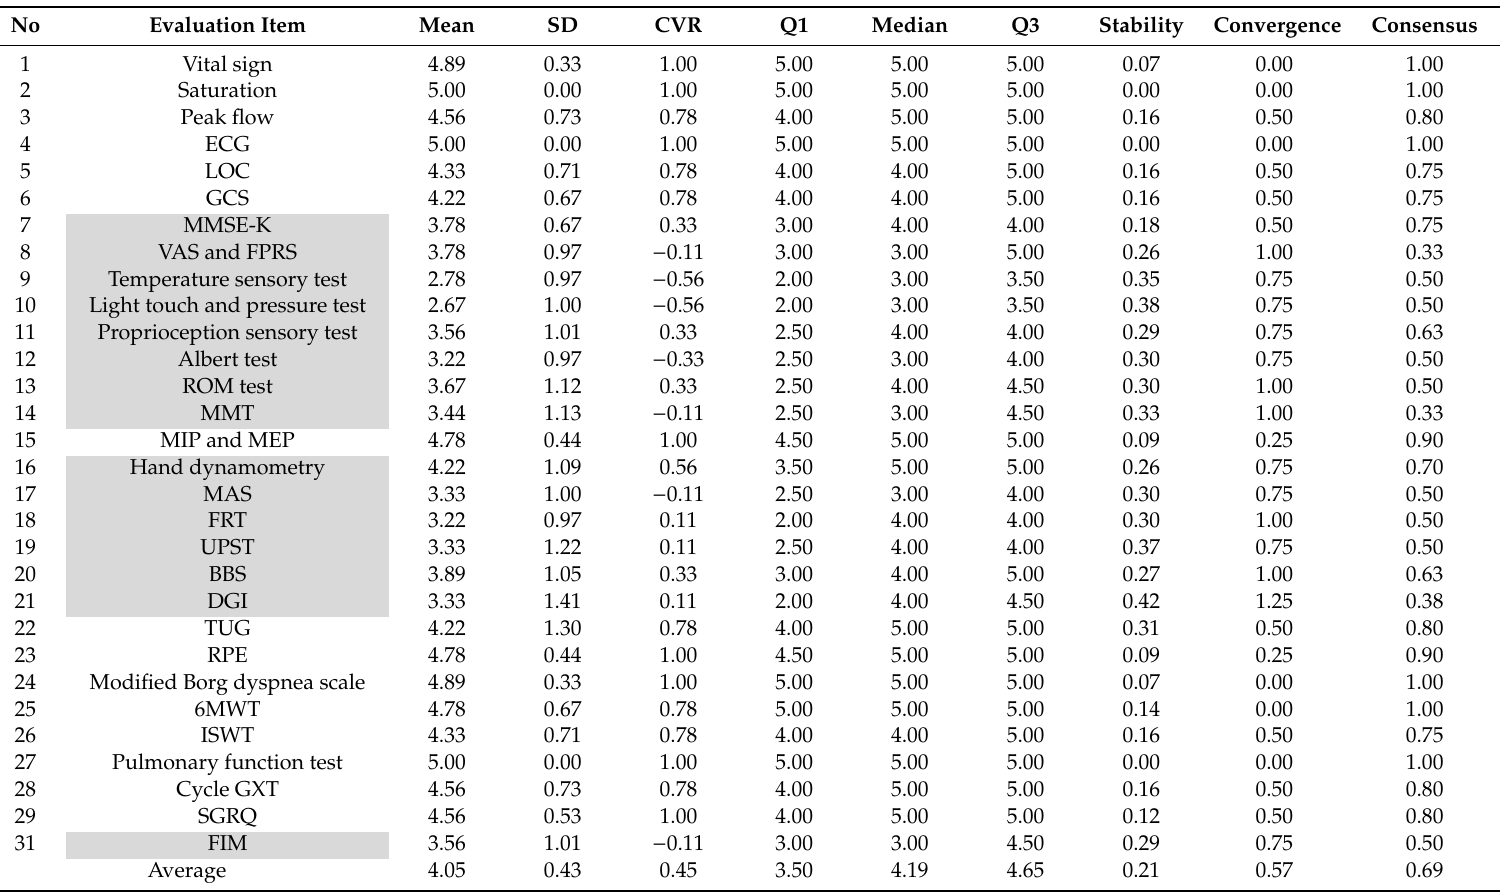
Table 9. Results of items after the first modified Delphi